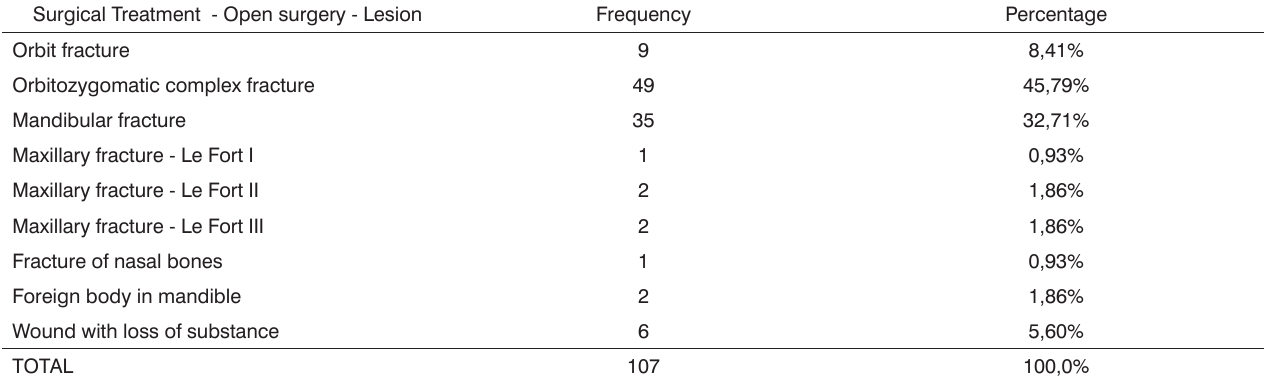
Table 7. Distribution and frequency of the population per surgical treatment, open surgery, types of lesions. Surgical Treatment - Open surgery -